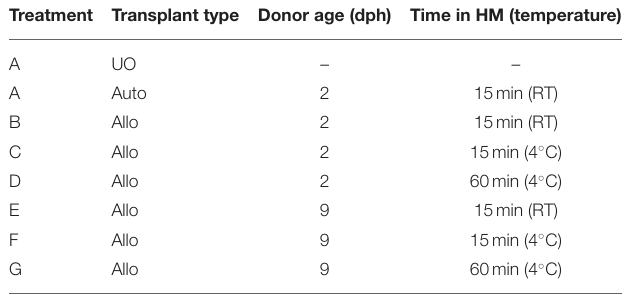
TABLE 1 | Study 1 treatment